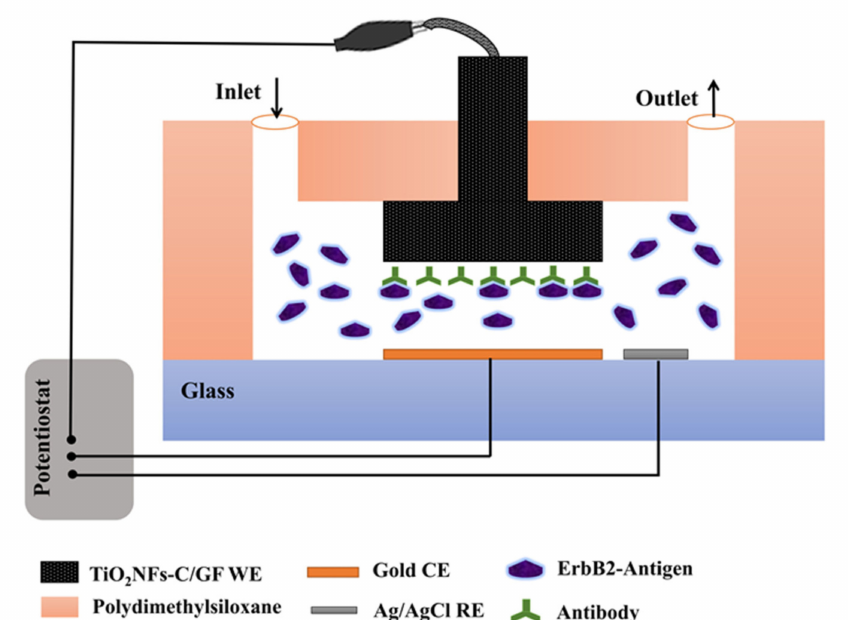
Figure 11. Schematic representation of the configuration of the microfluidic biosensor with 3D porous